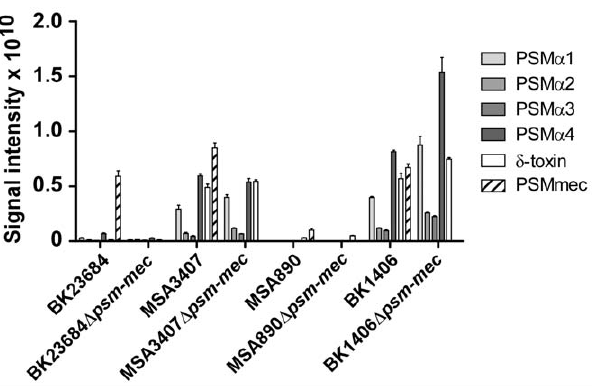
Figure 5. Impact of the psm-mec locus on the production of genome-encoded PSMs. Four MRSA strains of 3 different SCC mec types and their isogenic psm-mec deletion mutants were analyzed for production of all S. aureus PSM peptides ( a 1, a 2, a 3, a 4, b 1, b 2, d -toxin, mec) by RP-HPLC/MS. Production levels are shown for all peptides except for b 1 and b 2, for which production levels were in general very low.